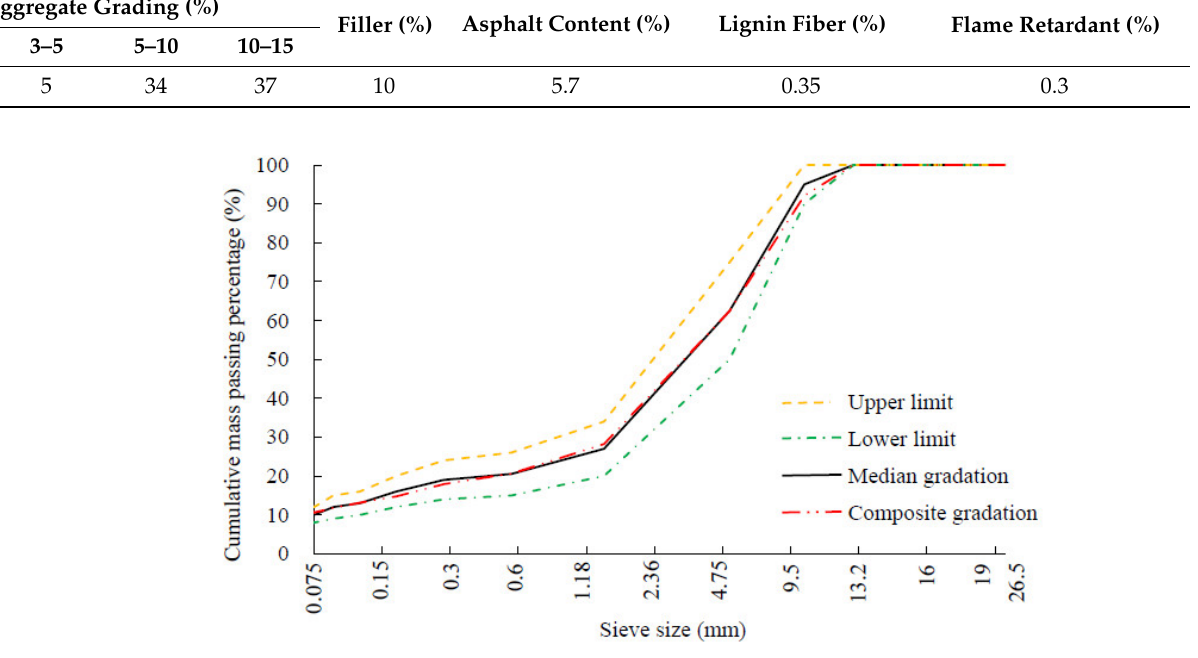
Table 4. Summary of asphalt mixture production ratio.